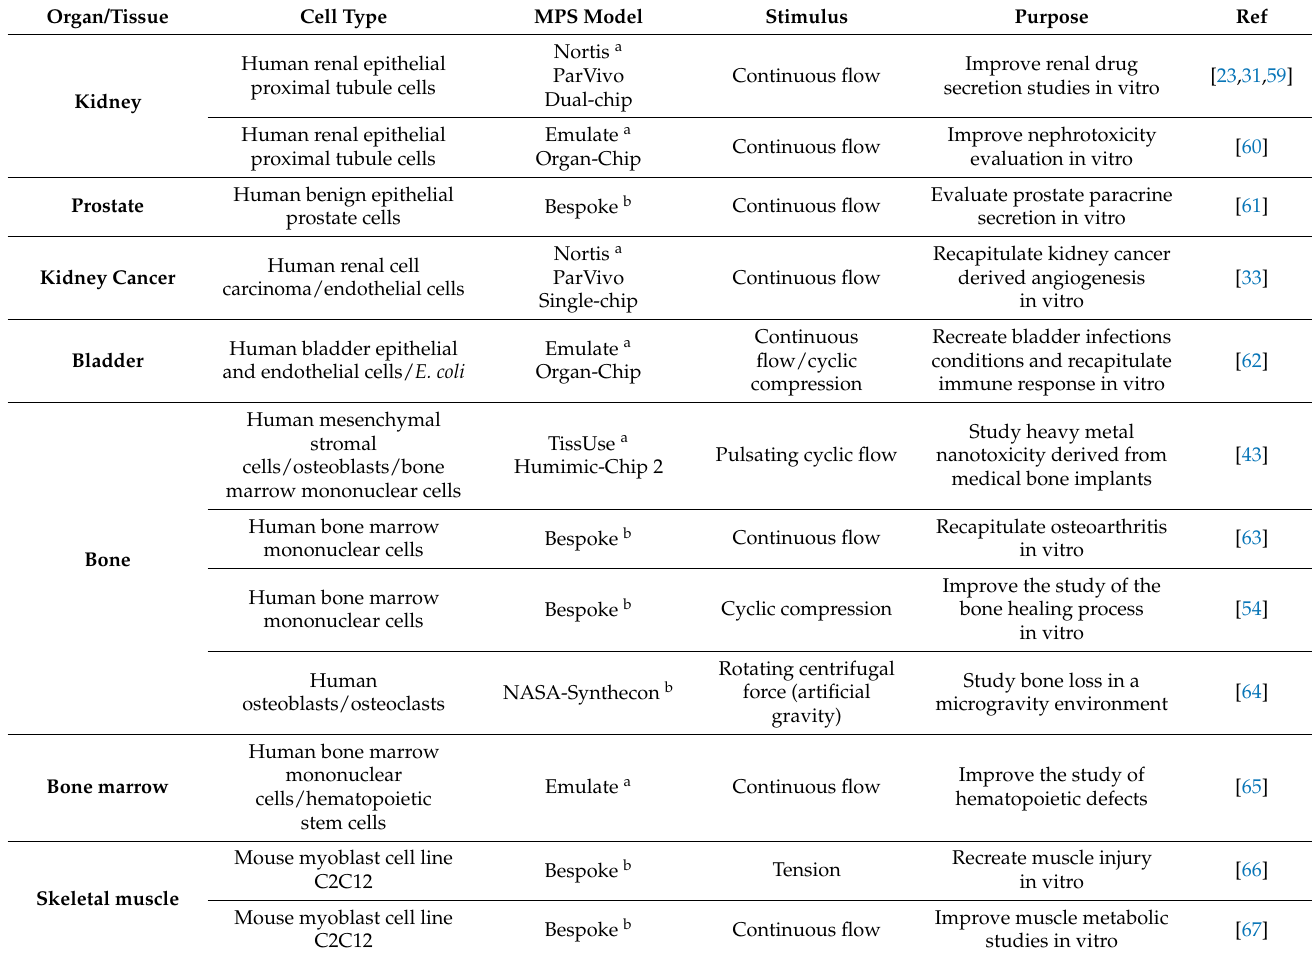
Table 1. Representative examples of current MPS models and applications used in biomedical research, namely in experimental urology and